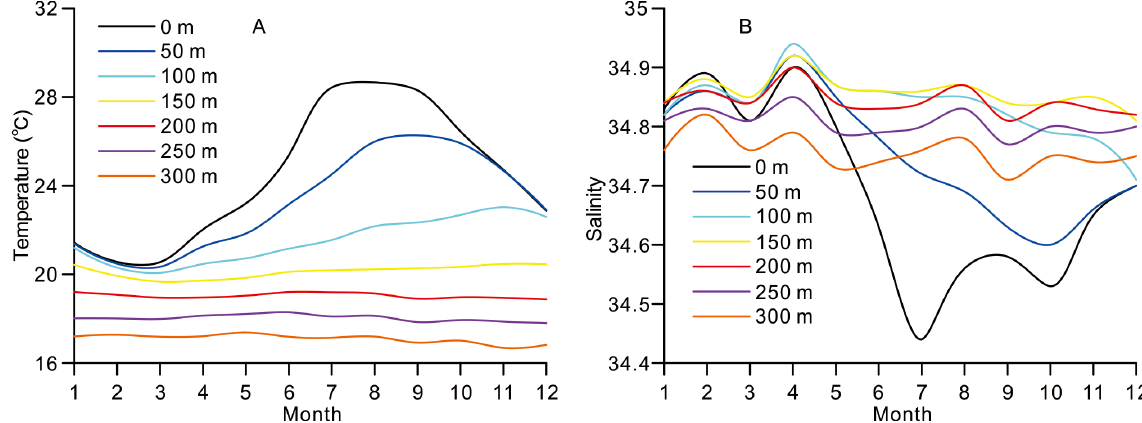
Figure 2. Monthly temperature and salinity for the upper 400m of the water column in the northern Okinawa Trough at 131–132 ◦ E and 28–29 ◦ N. (Data source: JODC (Japan Oceanographic Data Center) Data On-line Service